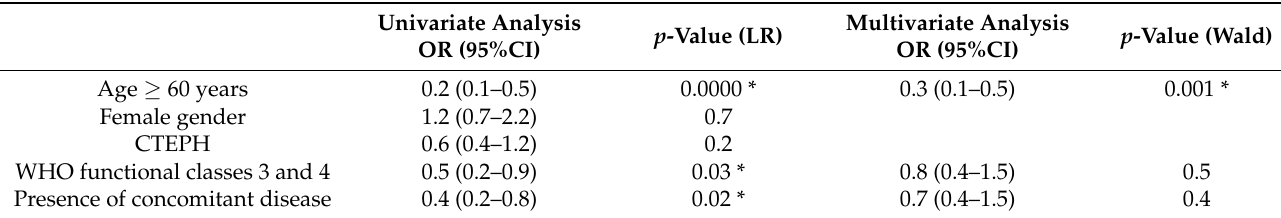
Table 5. Impact of different demographic and clinial factors on the freqency of side effects in PAH/CTEPH patients: results of the univariate and multivariate regression